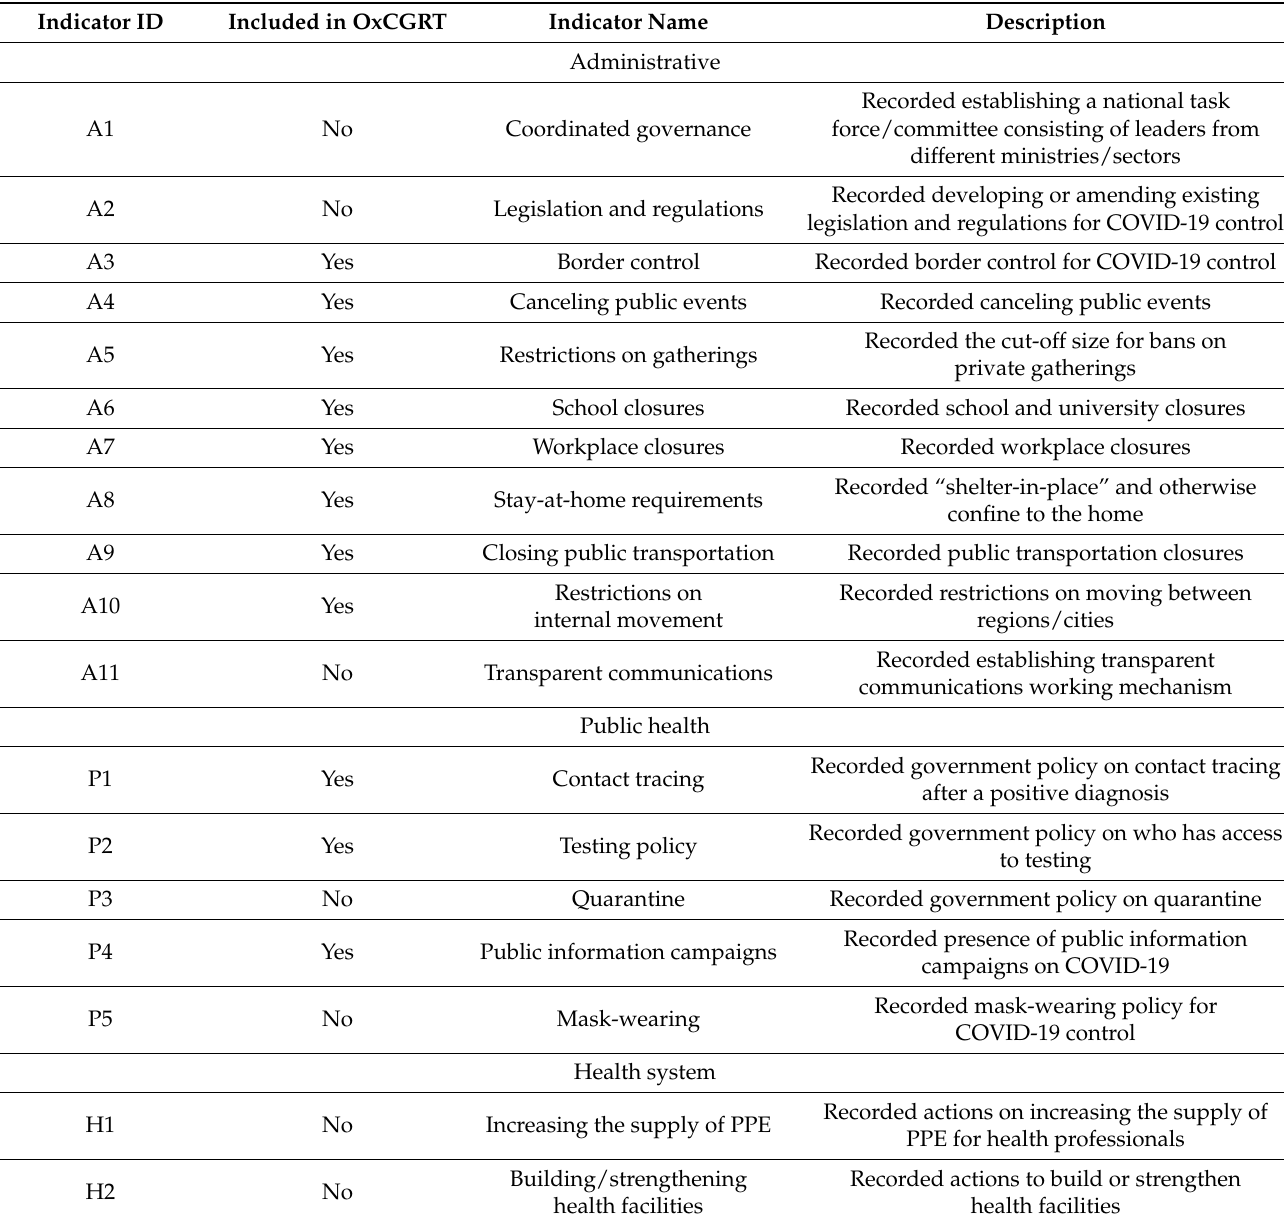
Table 1. List of the indicators included in the evaluation/measurement